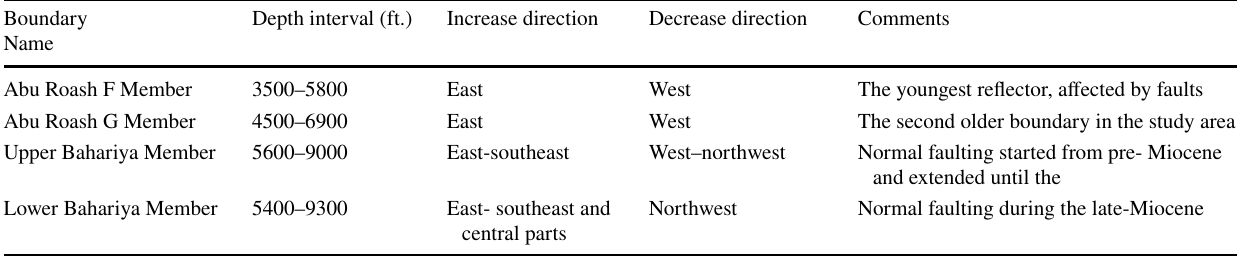
Table 1 The main parameters of the depth structure maps on top of the Abu Roash F and G members, as well as the Upper and Lower Bahariya members the study